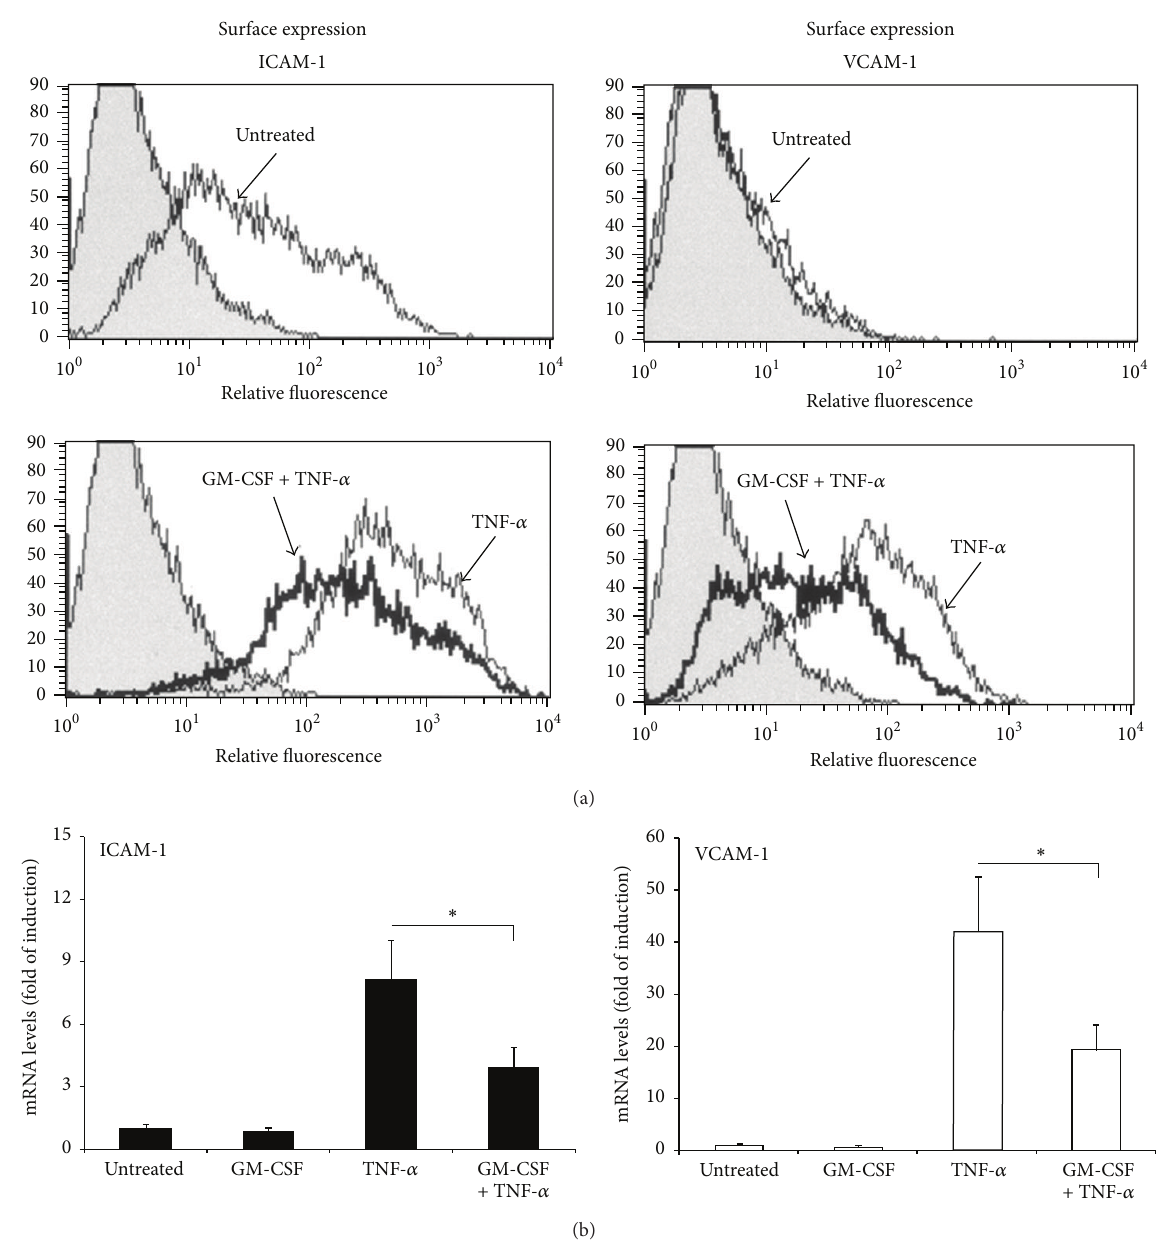
Figure 3: GM-CSF treatment downmodulates the TNF- 𝛼 induced expression of ICAM-1 and VCAM-1. VEC were left untreated or pretreated for 1 hour with GM-CSF (20 ng/mL) before addition of TNF- 𝛼 (5ng/mL). ICAM-1 expression and VCAM-1 expression were analyzed after 24 hours of TNF- 𝛼 stimulation. In (a), surface expression of ICAM-1 and VCAM-1 was analyzed by flow-cytometry. White histograms represent cells stained with monoclonal antibodies specific for the indicated antigens and grey histograms represent background mean fluorescence intensity obtained by staining the same cells with isotype-matched control antibodies. A representative panel for ICAM-1 expression and VCAM-1 expression in cultures, treated as indicated, is shown. In (b), the expression levels of ICAM-1 and VCAM-1 in VEC cultures treated as indicated were determined by quantitative RT-PCR. Results from amplifications, done in duplicate, are expressed as fold of untreated cells (set to 1), after normalization for the housekeeping gene. ∗ 𝑃 < 0.05